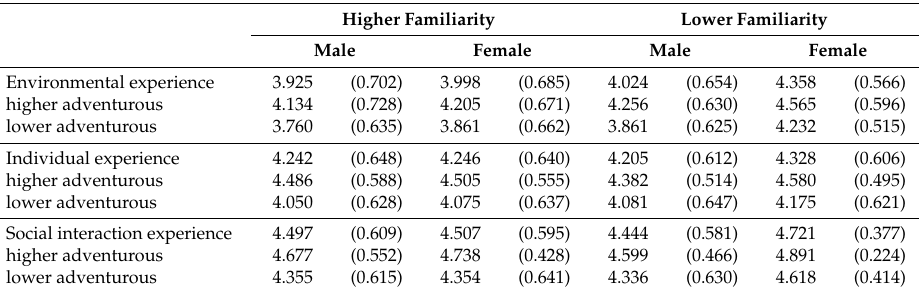
Table 7. MANOVA summary